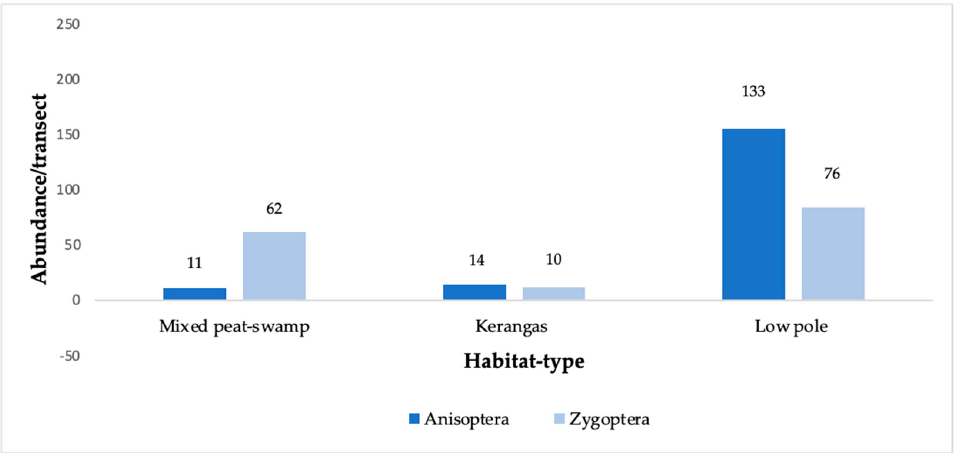
Figure 4. Suborder abundance with standard errors (SE) for habitat-types mixed peat swamp, kerangas, and low pole peat swamp forests.